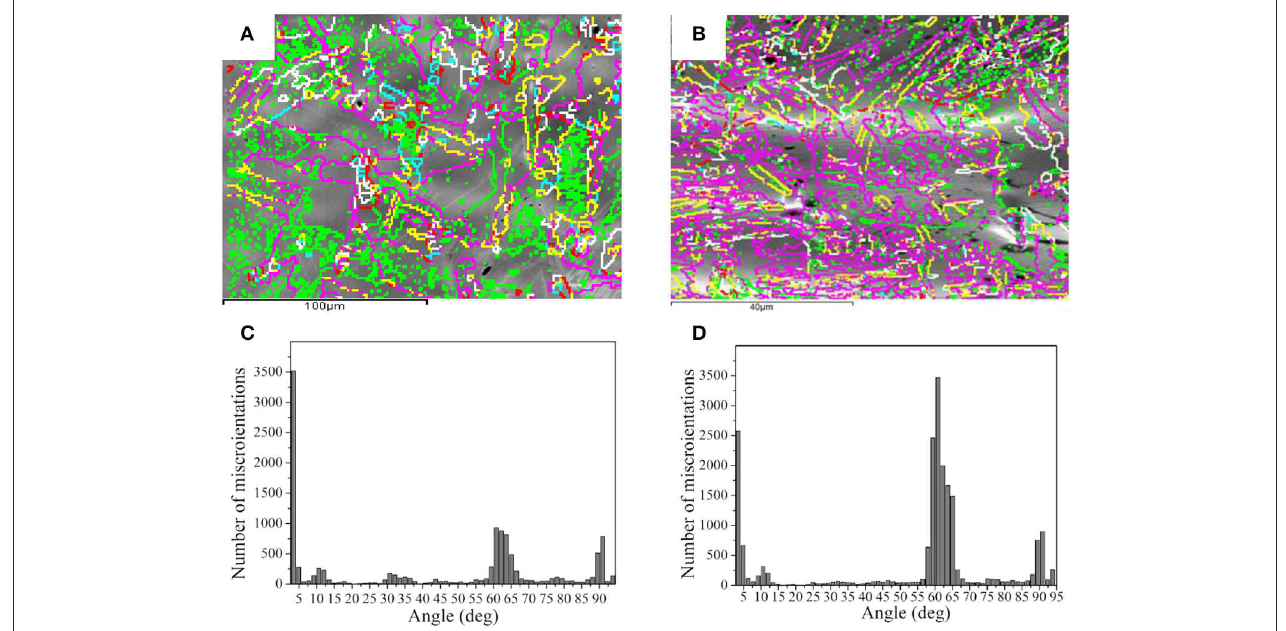
FIGURE 3 | Misorientations of TMCs after different heat treatment procedure. (A) HT1. (B) HT2. (C) Number of misorientations of HT1. (D) Number of misorientations of HT2.